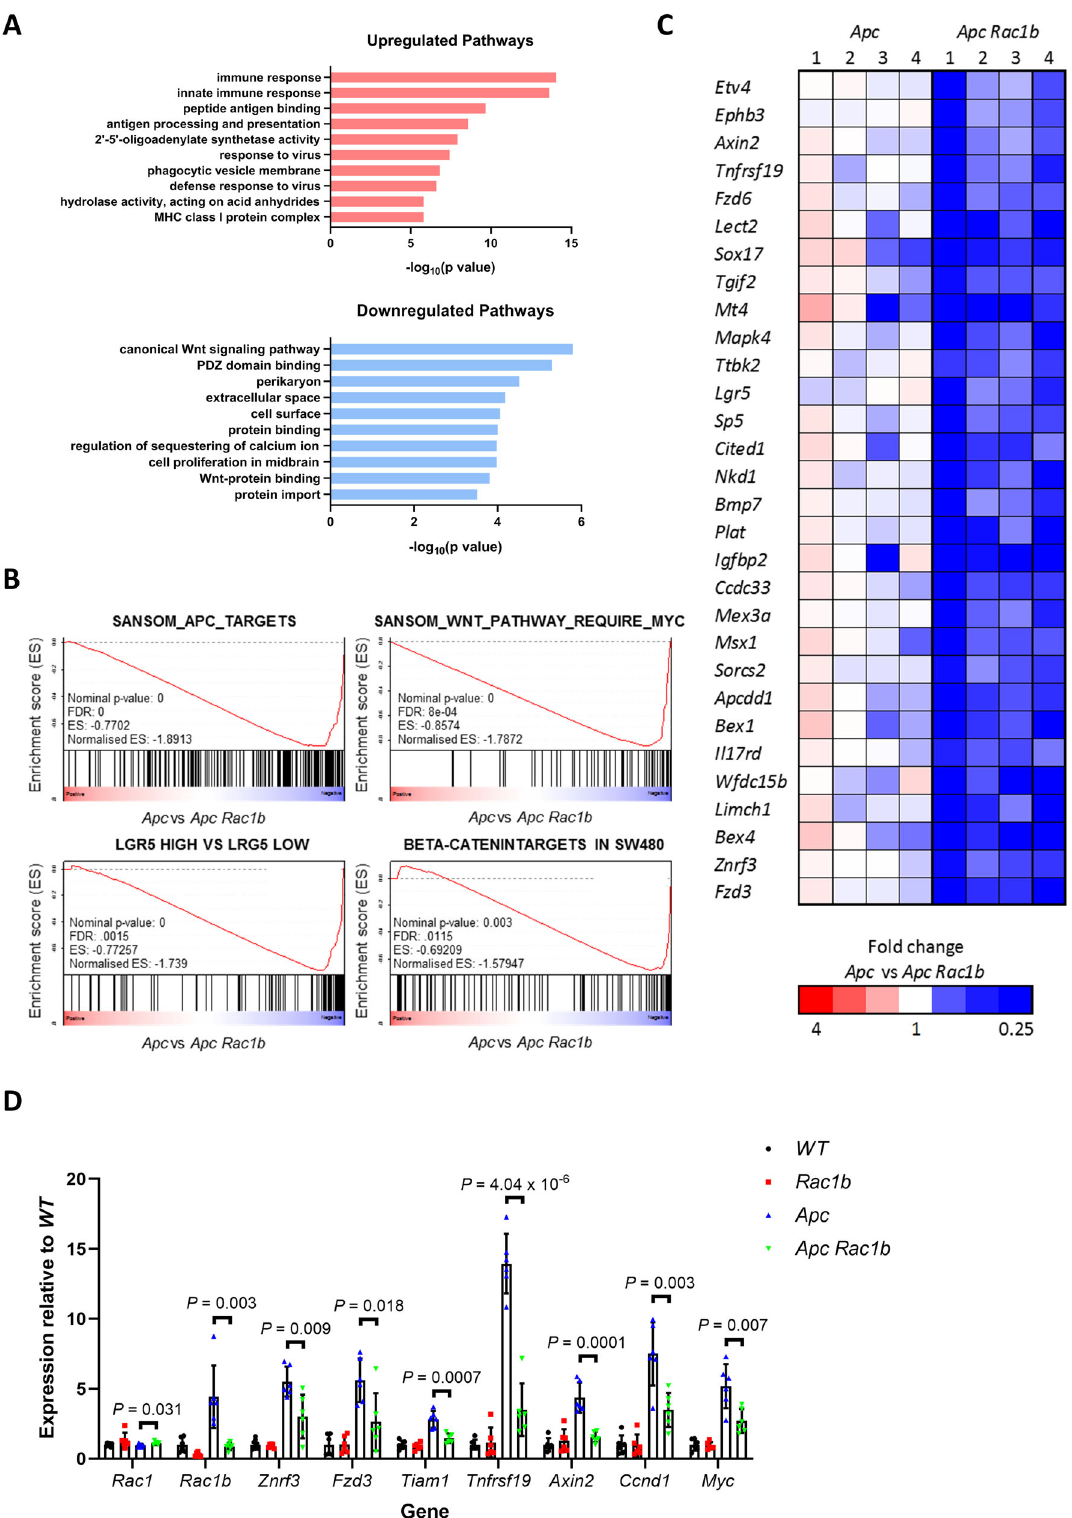
Fig. 4 Oncogenic WNT signalling is mediated by RAC1B. A Bar plot showing the top 10 signi fi cantly enriched upregulated and downregulated pathways in tumours from Apc vs Apc Rac1b mice. B GSEA plots of WNT target gene sets comparing tumours from Apc vs Apc Rac1b mice. C Heatmap of RNAseq expression values of WNT target genes and intestinal stem cell markers comparing tumours from Apc vs Apc Rac1b mice. D qRT-PCR analysis of various WNT target genes comparing tumours from Apc vs Apc Rac1b mice. As controls, matched normal tissue from these mice ( WT and Rac1b , respectively) are also included (data are presented as mean ± SD; two-tailed t -test; n = 6v6 mice). Source data are provided as a Source Data fi